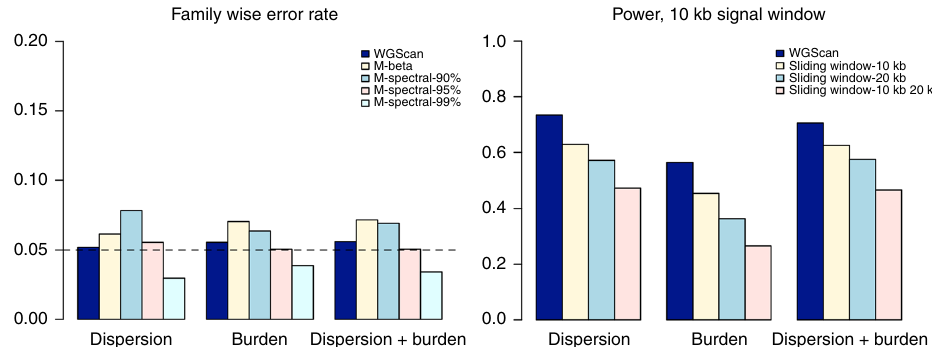
Fig. 2 Family-wise error rate and power-simulation studies. The trait is dichotomous, and region size is 200 kb. Several candidate window sizes were considered for WGScan, namely 5 kb, 10 kb, 15 kb, 20 kb, 25 kb and 50 kb. The left panel presents family-wise error rate comparison based on 10 5 replicates. M-Beta: method based on Beta distribution. M-Spectral-90%/95%/99%: method based on spectral decomposition, where leading eigenvalues account for 90%/95%/99% of the total variation (i.e., sum of all eigenvalues). The right panel presents power comparison based on 1000 replicates, with causal proportion 0.5%. WGScan: proposed test; sliding window: SKAT, Burden or SKAT-O test is applied to scan the region continuously using a sliding window of 10 kb, 20 kb or both, adjusted by Bonferroni correction for the total number of windows tested. Source data are provided as a Source Data fi